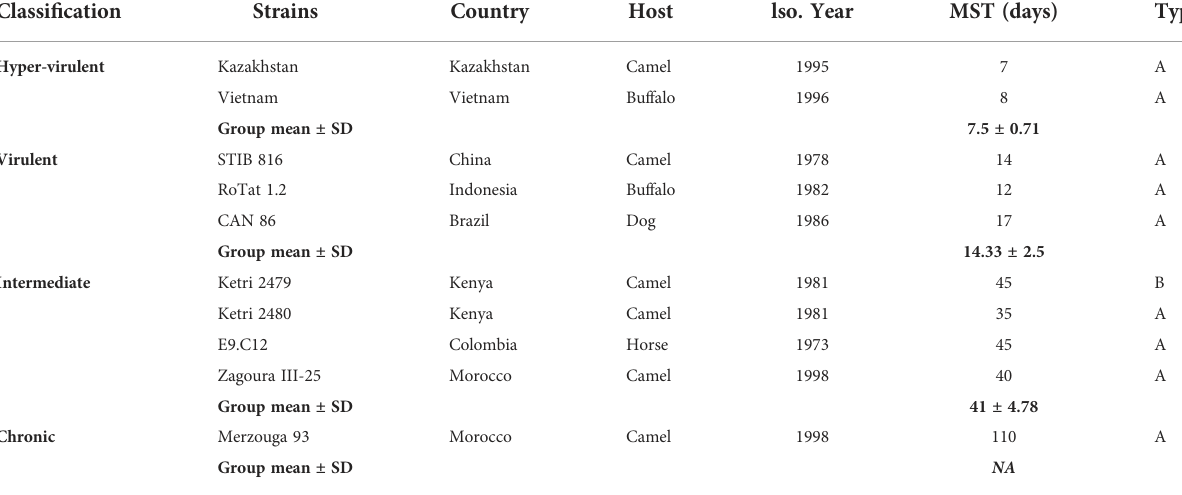
TABLE 1 Information of 10 T. evansi isolates and their classi fi cation based on mean survival time of infected mice. Classi fi